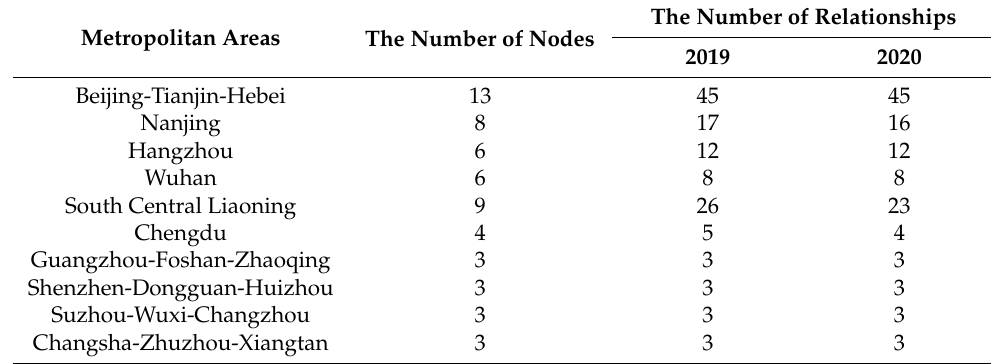
Table 3. The number of nodes and relationships in ten metropolitan areas from 2019 to 2020. Metropolitan Areas